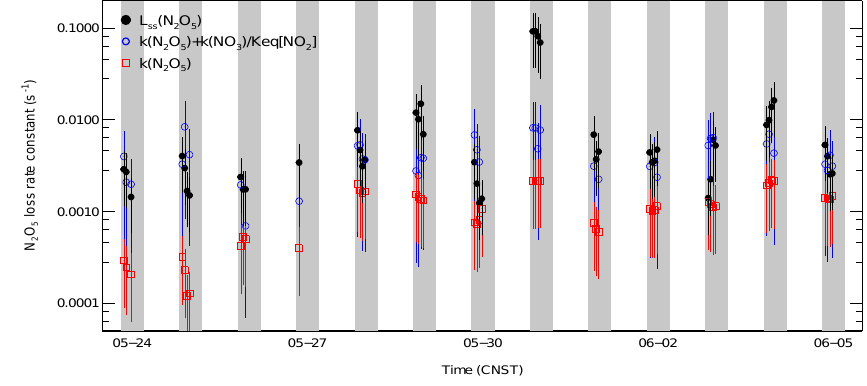
Figure 7. Time series of the individual N 2 O 5 loss terms and the loss rate constant of N 2 O 5 in steady state ( L ss (N 2 O 5 )).